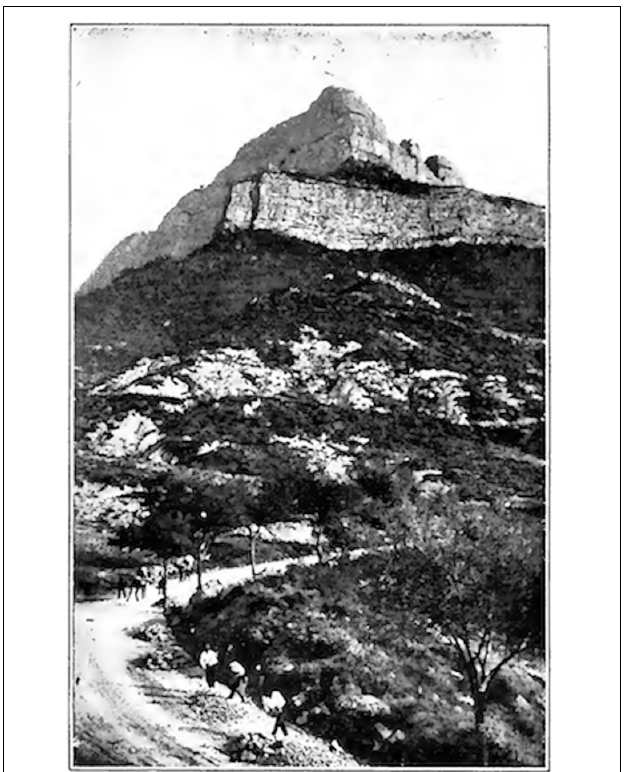
FIGURE 2 | Cajal’s photograph of Monte Oruel (in Jaca, Spain) seen from the west. Digital reproduction of Plate 7 in Santiago Ramón y Cajal, Recuerdos de mi vida , Volume 1 (Imprenta y libería de Nicolás Moya, Madrid, 1917). Available at http://www.gutenberg.org/ebooks/58331.